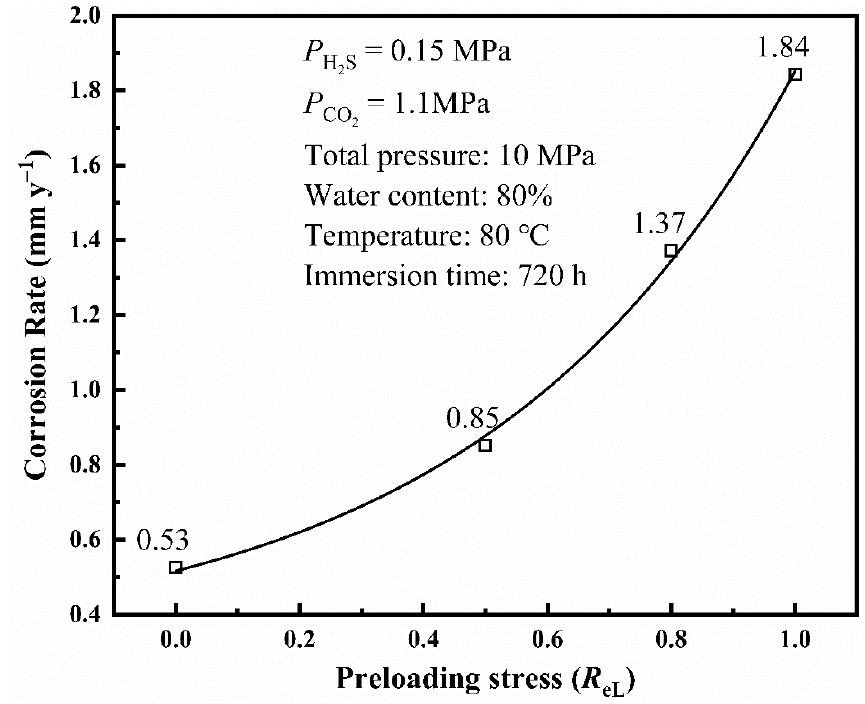
Figure 7. Corrosion rate of L80 steel with different preloading stresses obtained from immersion test.